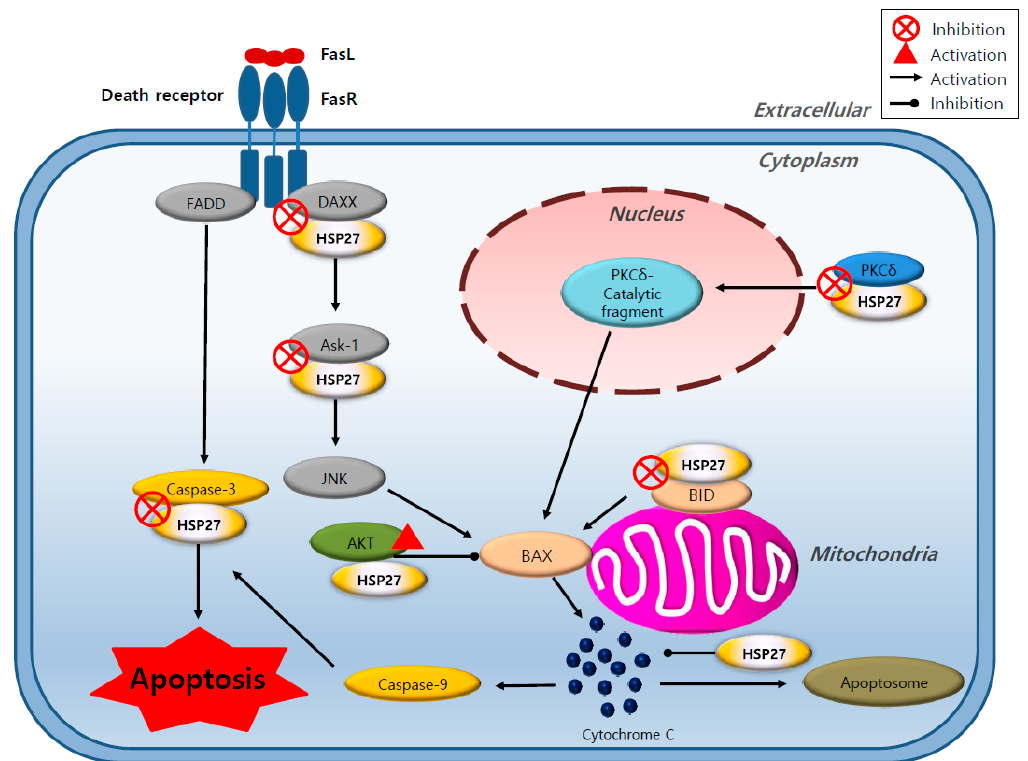
Figure 4. Role of heat shock protein 27 (HSP27) in different cellular apoptotic processes. HSP27 inhibits apoptosis by integrating with different signaling pathways, including the extrinsic and intrinsic apoptosis pathway. HSP27 inhibits Bcl-2-associated X protein (BAX) by directly binding to death domain associated protein (DAXX) or apoptosis signal-regulating kinase-1 (Ask-1) to inhibit its function, which enhances AKT activity inhibiting BH3 interacting-domain death agonist (BID) or protein kinase C delta type (PKC δ ) function. HSP27 inhibits caspase 3, which directly functions in cellular apoptosis. HSP27 contributes to cell survival.